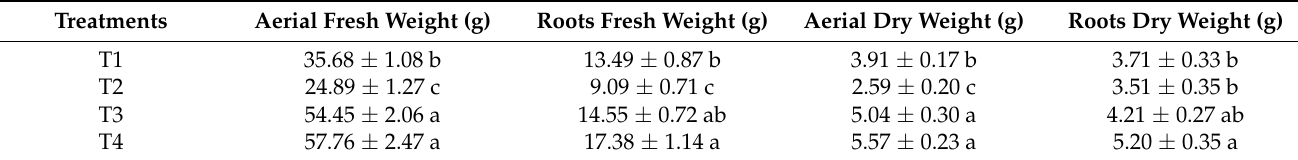
Figure 2. Effect of endophytic B. bassiana inoculum on the growth of F. oxysporum -infected tomato plants: T4 ( B. bassiana and FOL), T3 ( B. bassiana ), T2 (FOL) and T1 (Control) treatments: effect on plant heights ( A ) and leaf discoloration in T2 ( B ). Table 2. Effect on the endophytic activity of B. bassiana on the fresh weight and dry weight of roots and aerial